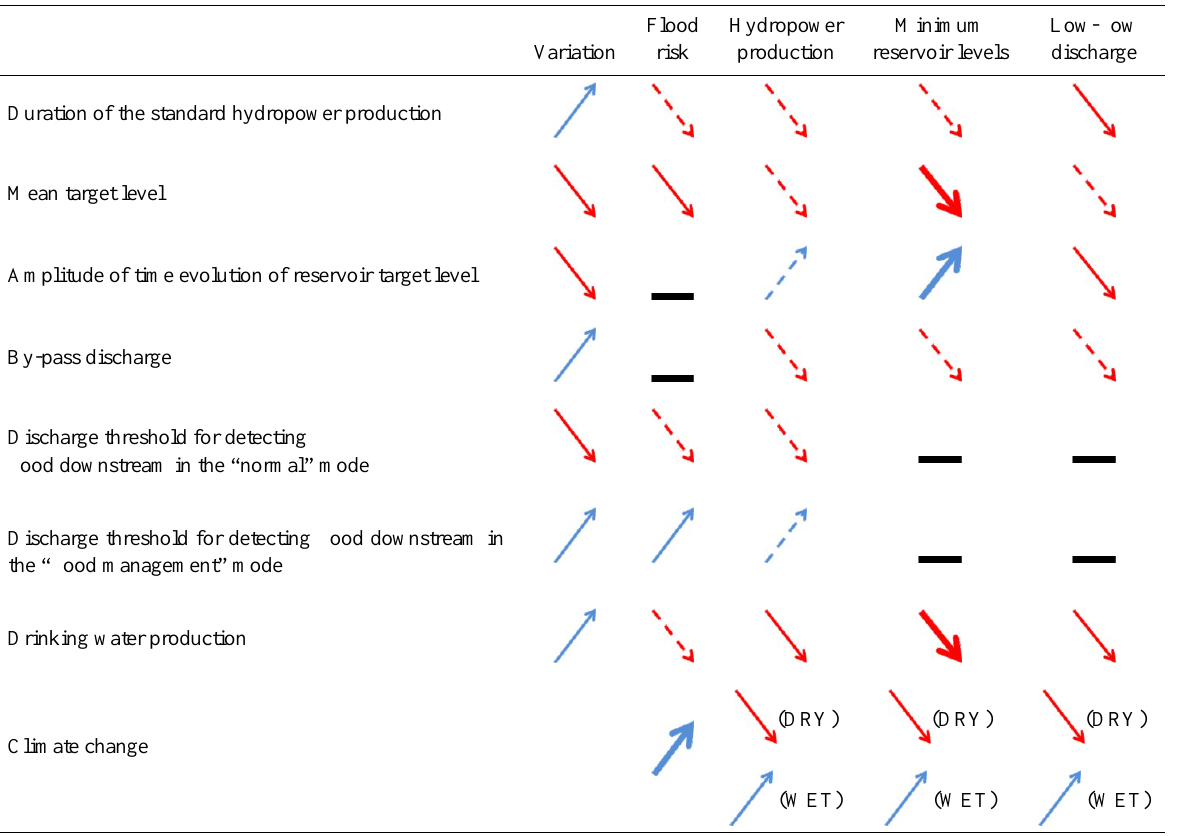
Table 9. Qualitative influence of the reservoir management parameters and of climate change on the indicators of reservoir